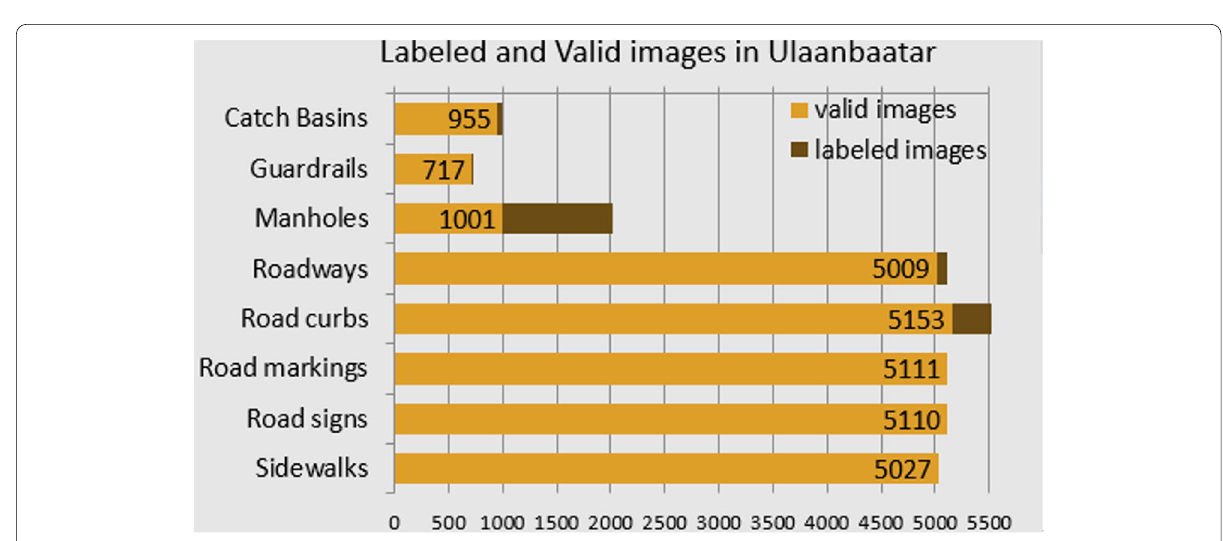
Fig. 21 The numbers of labeled and valid images of transportation facilities in